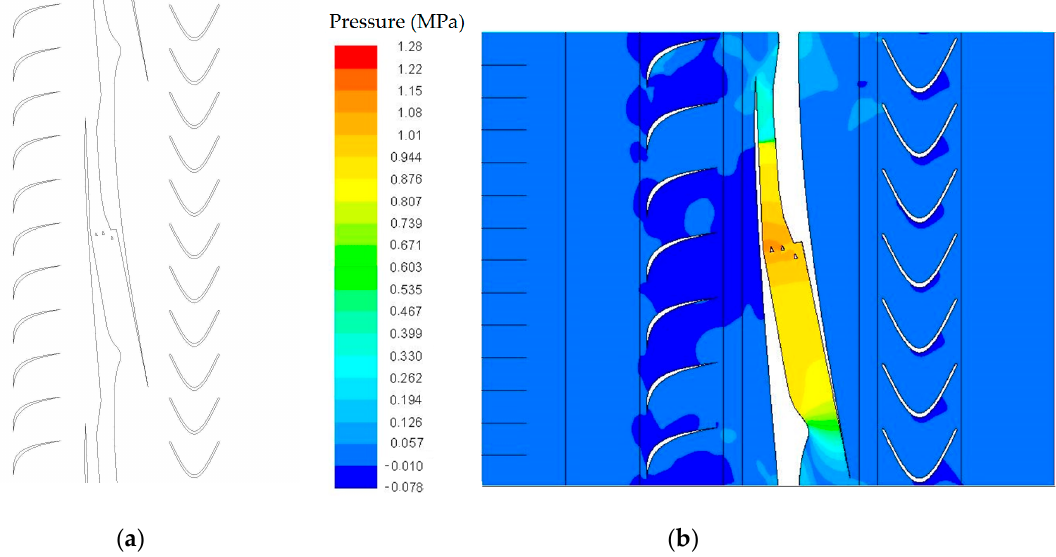
Figure 19. ( a ) Engine components’ geometry showing the subsonic compressor vanes, main rotor channels (supersonic compressor, insulator, combustion chamber, expansion nozzle), and turbine blades driving subsonic compressor; and ( b ) an example pressure distribution.